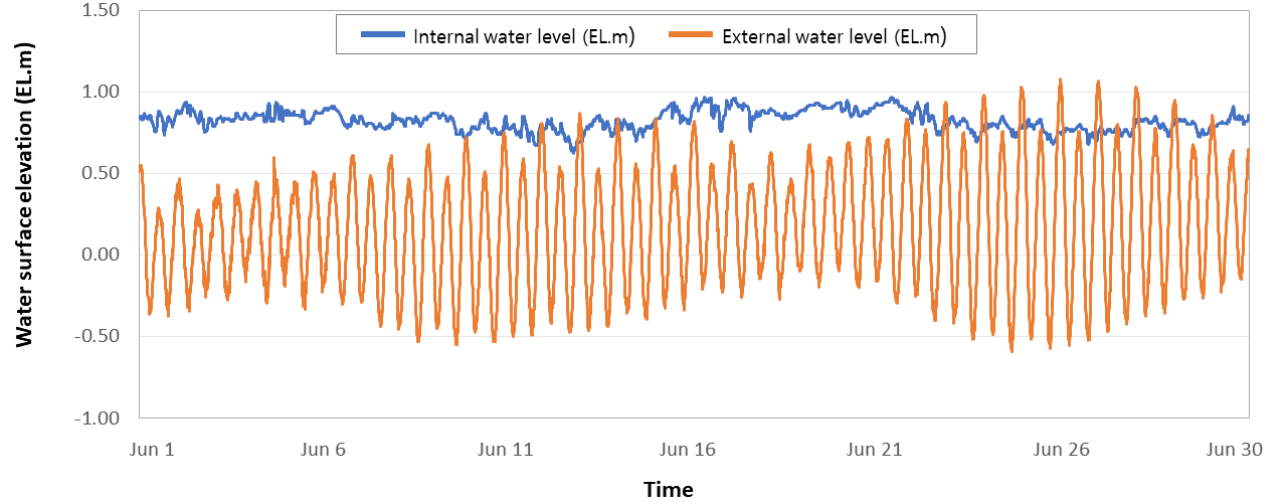
Figure 2. Example time series of the observed water level moving in and out of the estuary gate between 1 Jun 2021 to 30 Jun 2021(the water level observed on the riverside refers to the internal water level, and the water level on the seaside indicates the external water level).